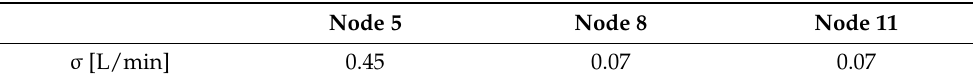
Table 4. Standard deviation between the measured tapped flow rates and the numerically simulated flow rates. Node 5 Node 8 Node 11 σ [L/min] 0.45 0.07